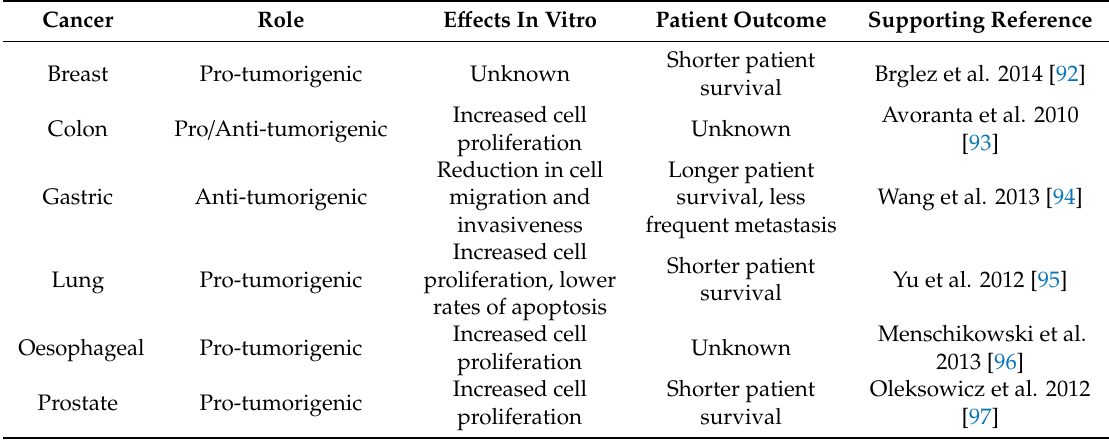
Table 2. Role of hGIIA in some cancers. Adapted from Brglez et al. 2014